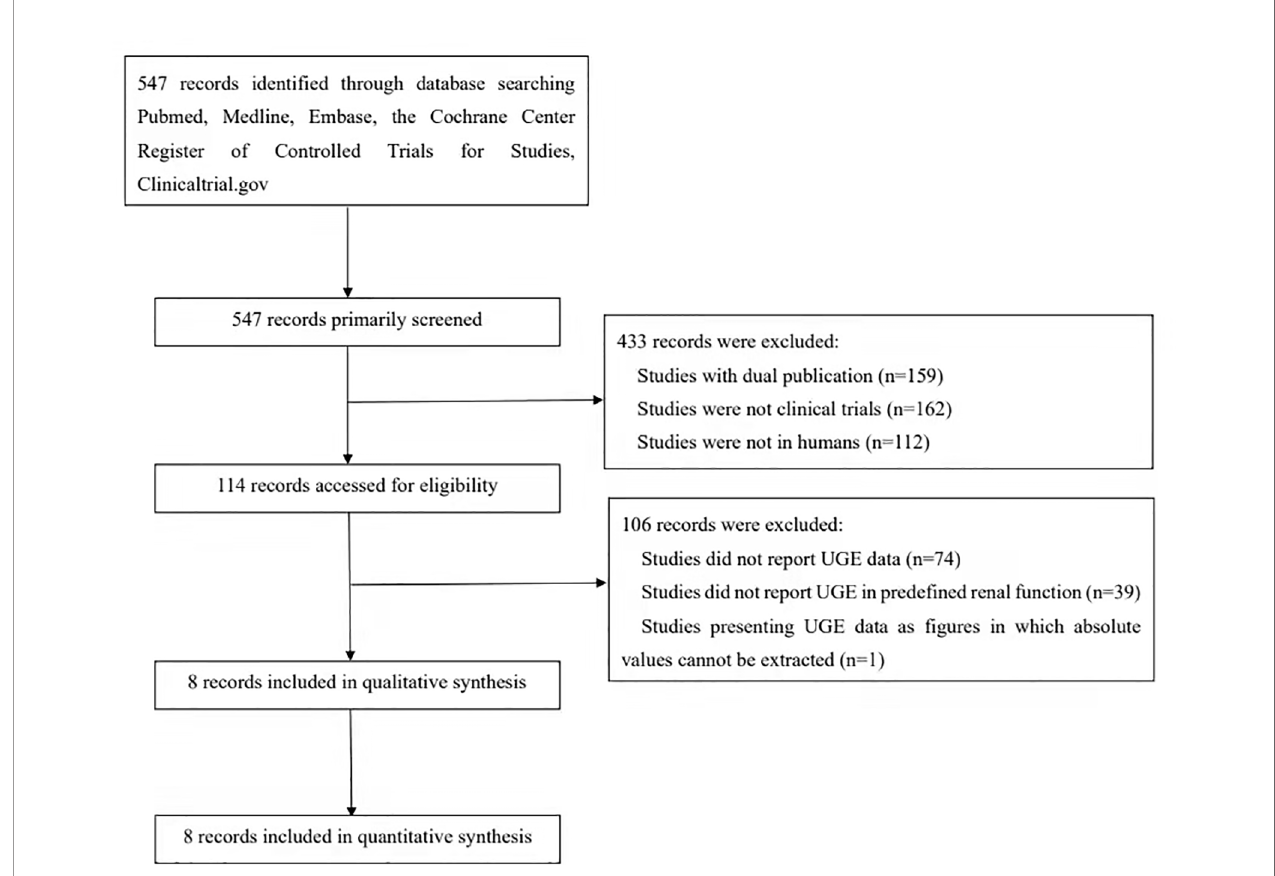
FIGURE 1 | Flow chart of the included